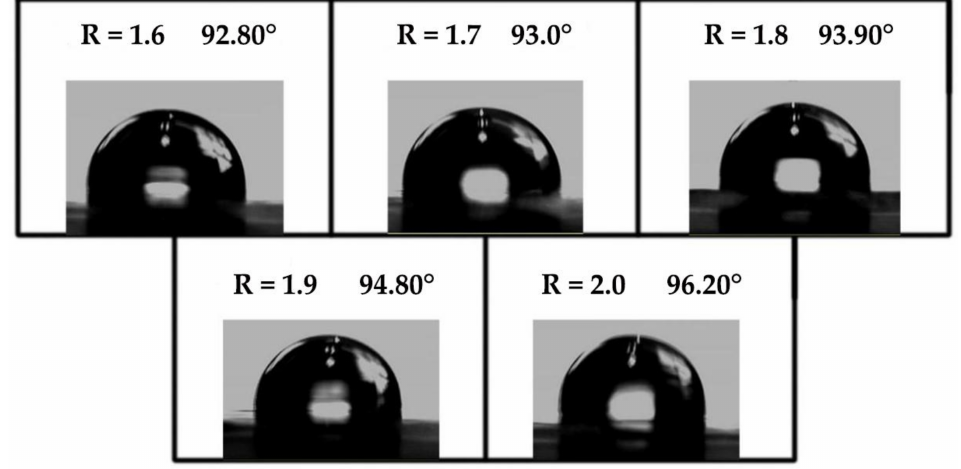
Figure 10. Water contact angles of SPU films with different R values.